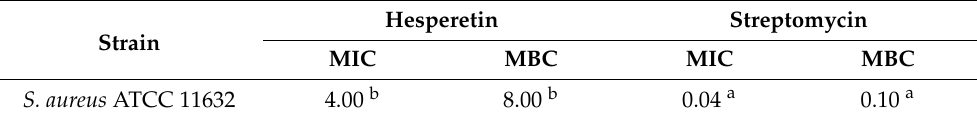
Table 2. Antibacterial activity of hesperetin, results are in mg/mL. MIC- minimal inhibitory con- centration; MBC- minimal bactericidal concentration. Different letters (a, b) in each row indicate a significant statistical difference between the samples ( p < 0.05). MIC and MBC values are compared separately.